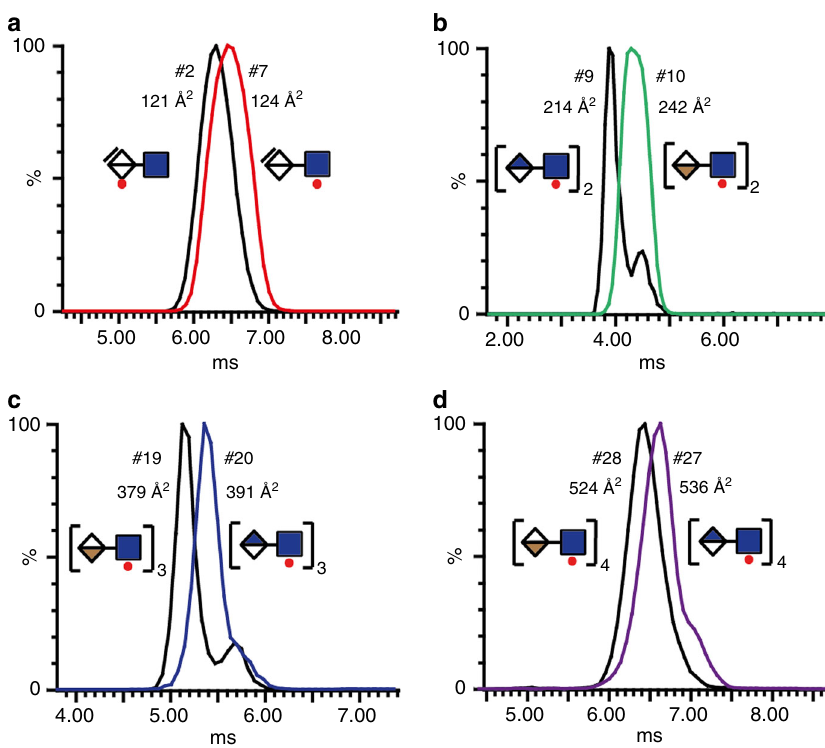
Fig. 2 Drift tube ion mobility separation (DTIMS) of isomeric HS standards. Intact HS standards were subjected to DTIMS to de fi ne collision cross section (CCS) values. Variant degrees of separation were observed for ( a ), Disaccharides Δ UA-GlcNAc6S ( #2 ) and Δ UA2S-GlcNAc ( #7 ). b Tetrasaccharides GlcA-GlcNAc6S-GlcA-GlcNAc6S-R 1 ( #9 ) and IdoA-GlcNAc6S-IdoA-GlcNAc6S-R 1 ( #10 ), where R 1 is (CH 2 ) 5 NH 2 . c Octasaccharides